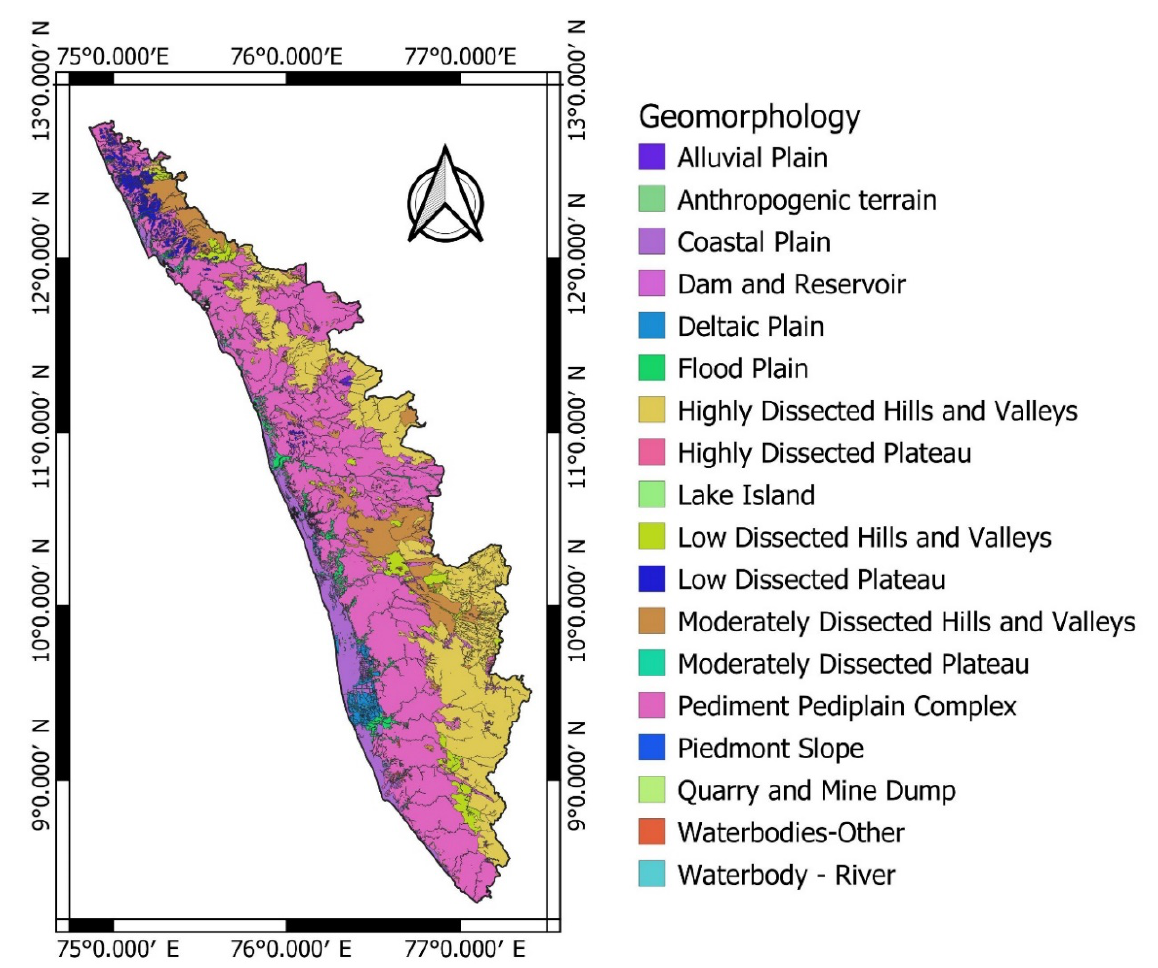
Figure 5. Kerala geomorphology map with legend subdivisions. During the month of April, a total of 32 locations had greater percentages for slope to be positive or negative. The well location names are Chamravattom, Pattambi, Quilandy,